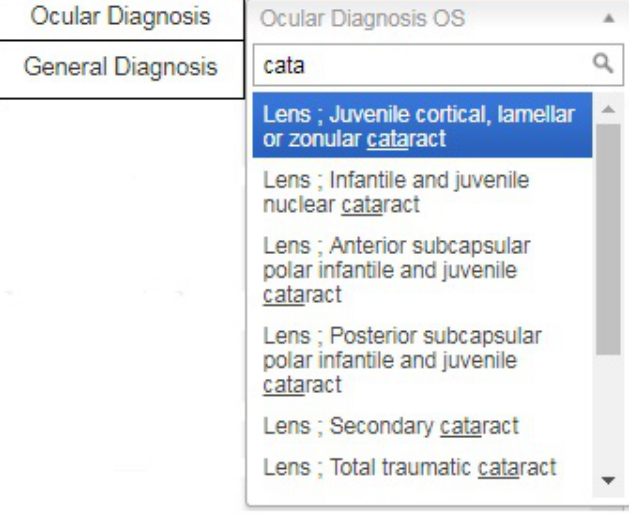
Figure 4. Data entry of diagnosis through search engine: The initial letters of the diagnosis are entered and the system automatically suggests the related diagnosis, thus reducing the effort in typing or selecting multiple